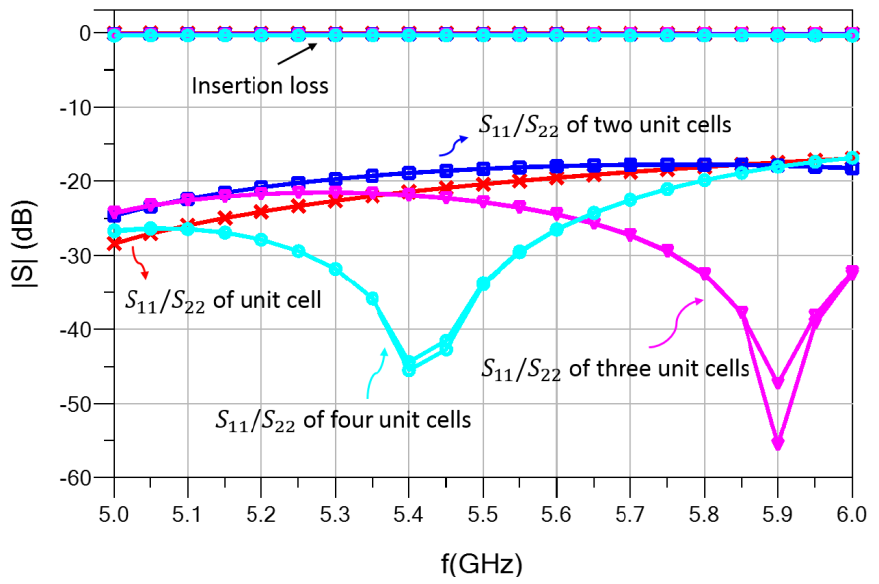
Figure 4. Simulated S parameter results of the proposed unit cell and cascaded unit cells P-CRLH